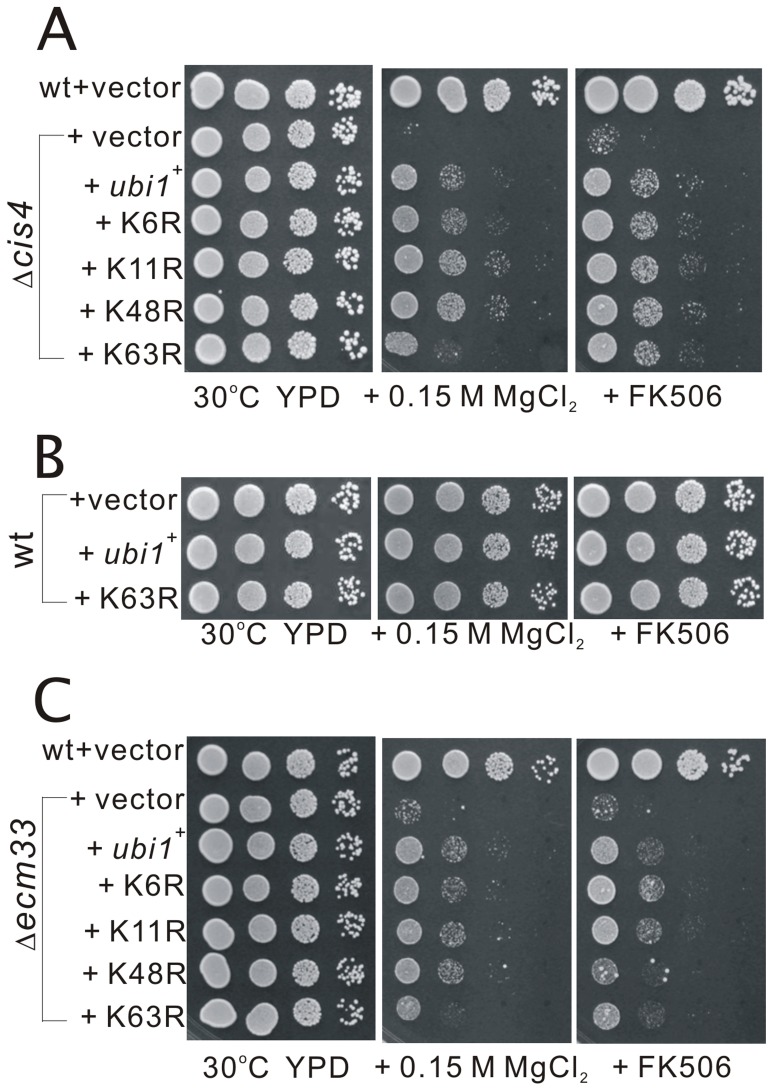
K6-, K11-, or K48- linked poly-ubiquitylation is not involved in the suppression of the phenotypes of Δcis4 mutant.(A) The Δcis4 cells harboring the vector for the indicated proteins were spotted onto plates containing YPD, YPD plus 0.15 M MgCl2, or YPD plus 0.5 μg/ml FK506, and then incubated for 4 days at 30°C. (B) Wild-type cells harboring the vector for the indicated proteins were spotted onto plates containing YPD, YPD plus 0.15 M MgCl2, or YPD plus 0.5 μg/ml FK506, and then incubated for 4 days at 30°C. (C) The Δecm33 cells harboring the vector for the indicated proteins were streaked onto plates containing YPD, YPD plus 0.15 M MgCl2, or YPD plus 0.5 μg/ml FK506, and then incubated for 4 days at 30°C.